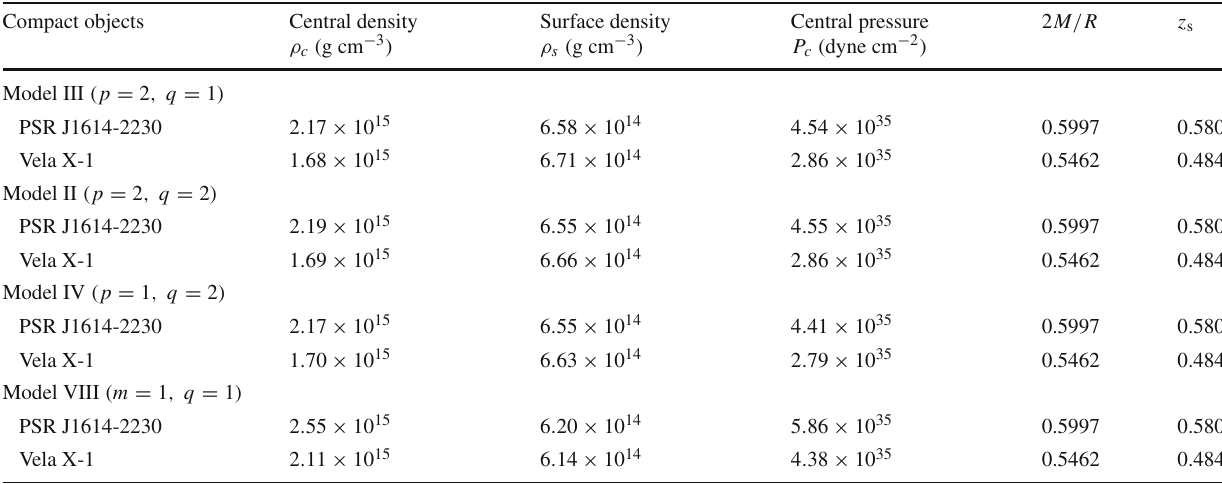
Table 3 Values of the physical quantities such as central density, surface density, and central pressure of various compact objects listed in Table 2 Compact